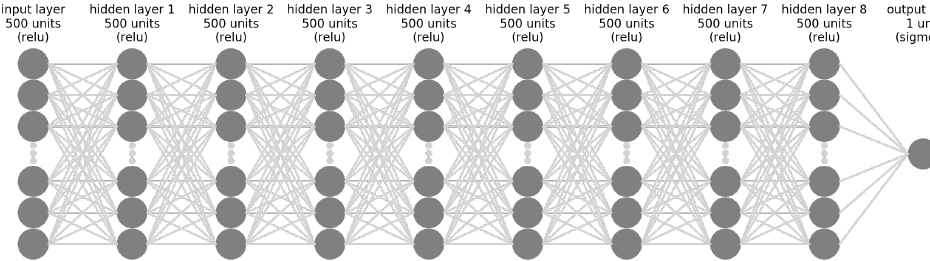
Figure 6. Deep neural network architecture that provided the best performance.